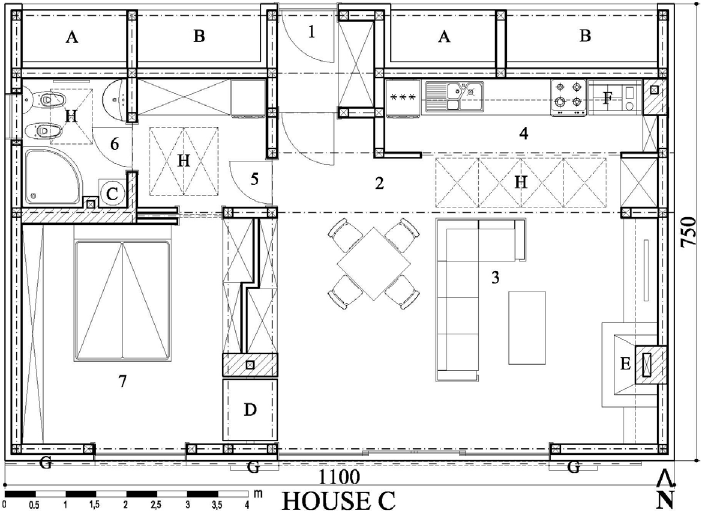
Fig. 9. Plan of House C.